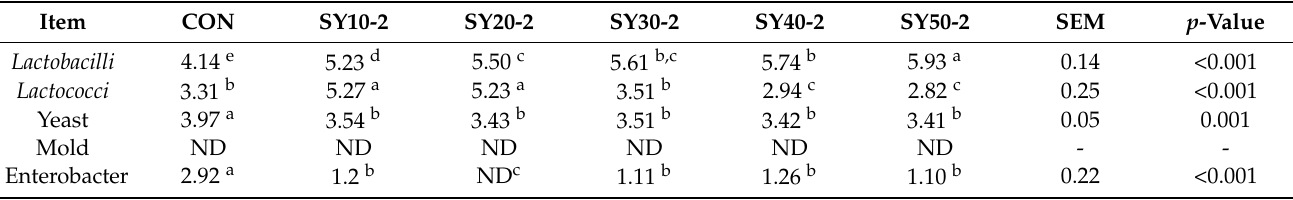
Table 4. Microbiological analysis results of corn silages, log10